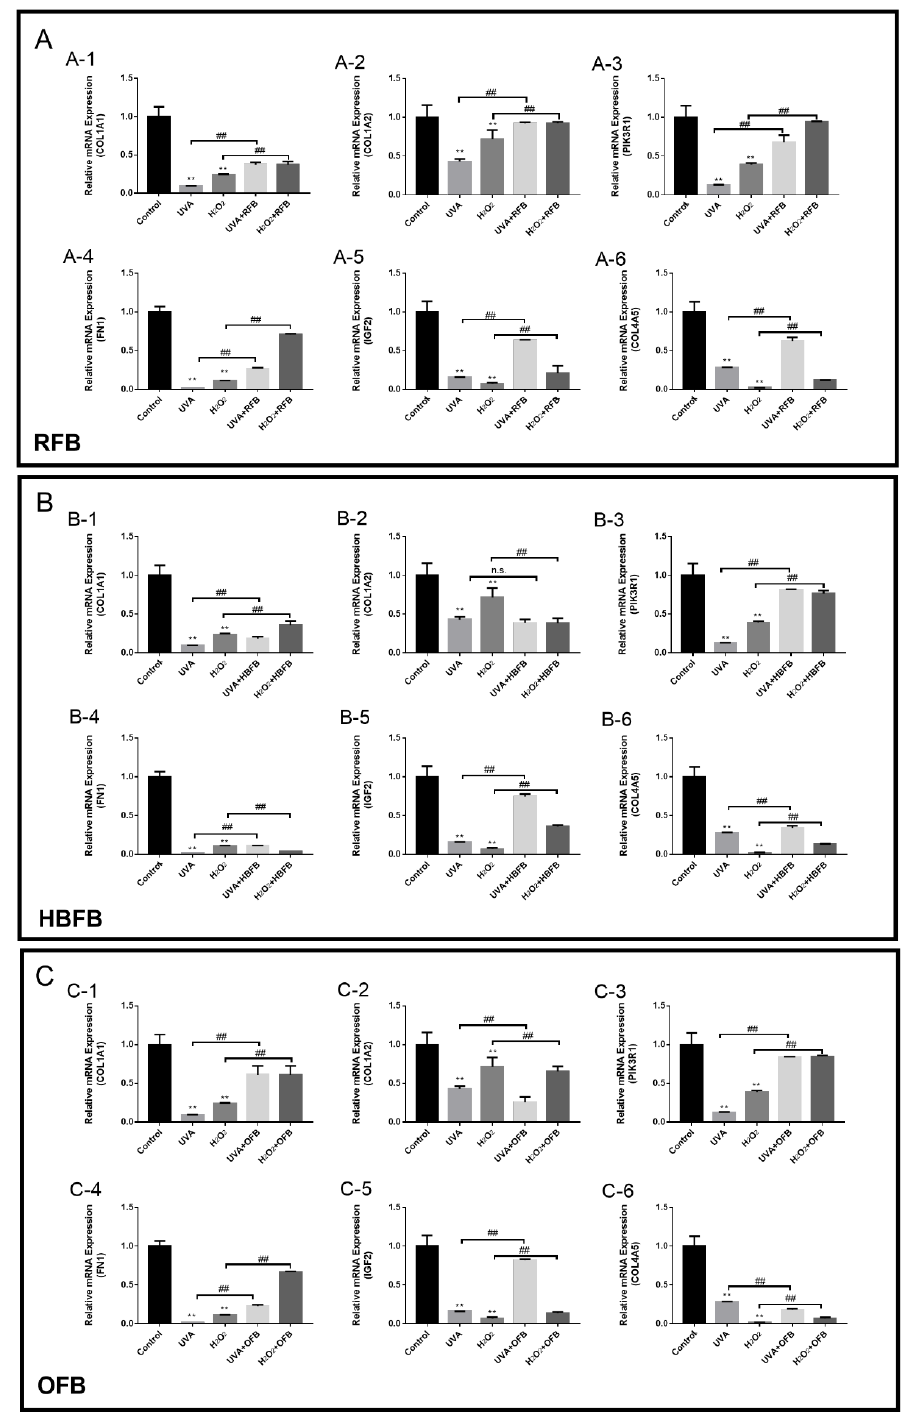
Figure 5. The relative gene expression changes after the repair of rice fermentation broth (RFB, A ), highland barley fermentation broth (HBFB, B ) and oats fermented broth (OFB, C ) on UVA and H 2 O 2 injury. RFB, HBFB, and OFB are three kinds of S. commune fermentation broths . Genes, COL1A1 ( A-1 , B-1 , C-1 ), COL1A2 ( A-2 , B-2 , C-2 ), PIK3R1 ( A-3 , B-3 , C-3 ), FN1 ( A-4 , B-4 , C-4 ), IGF2 ( A-5 , B-5 , C-5 ) and COL4A5 ( A-6 , B-6 , C-6 ) were measured. The UVA bar represented the model established by UVA (15 J/cm 2 ) treatment; the H 2 O 2 bar represented the model established by H 2 O 2 (1000 µ mol/L for 30 min) treatment. **, p < 0.01, the UVA/H 2 O 2 -induced model compared with the DMEM-treated control. ## p < 0.01 and n.s. p > 0.05, RFB, HBFB, and OFB treated cells compared with the